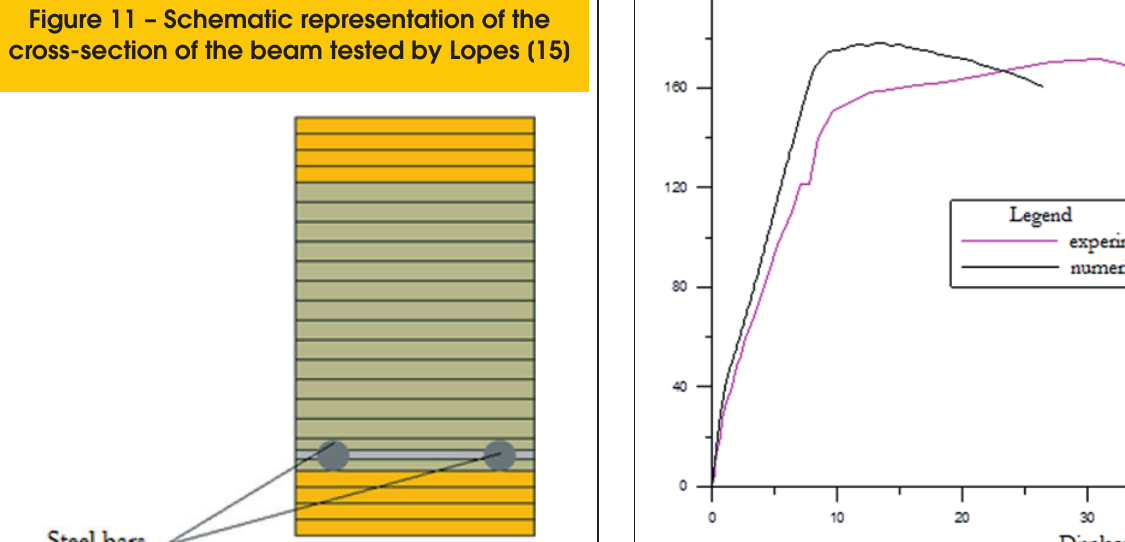
Figure 11 – Schematic representation of the cross-section of the beam tested by Lopes [15]